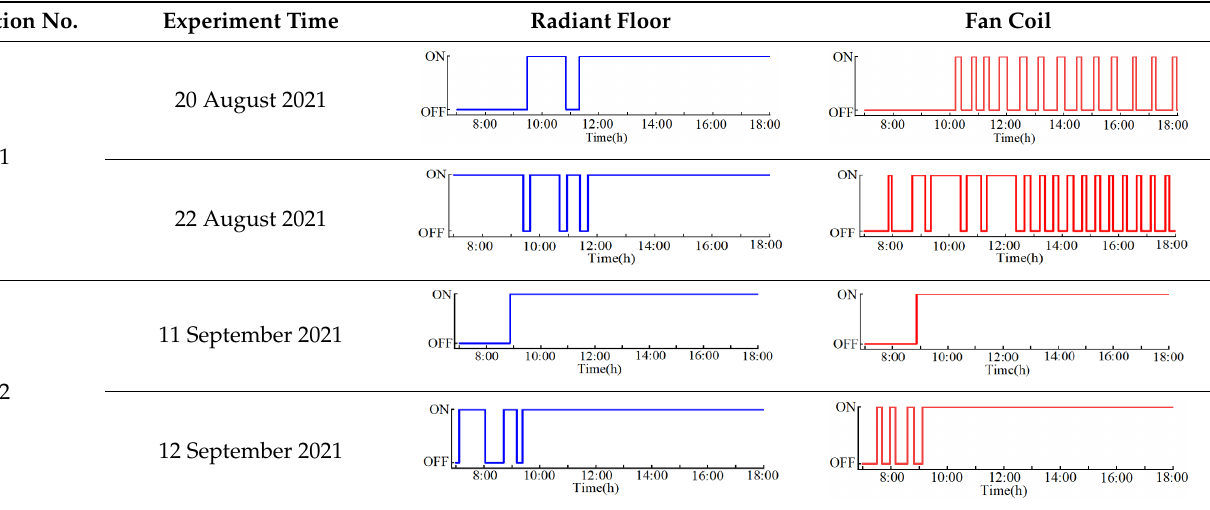
Table 6. Summary of the combined cooling system start/stop strategy under different outdoor weather conditions.